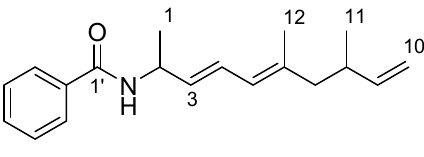
Figure 1. Structure of haliamide ( 1 ).